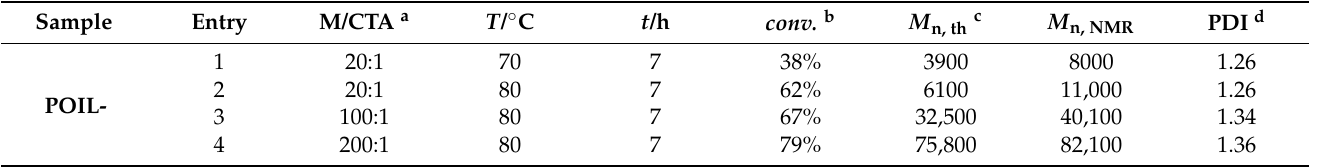
Table 1. Data from RAFT polymerizations of ILA and the resulting homopolymer POIL-x